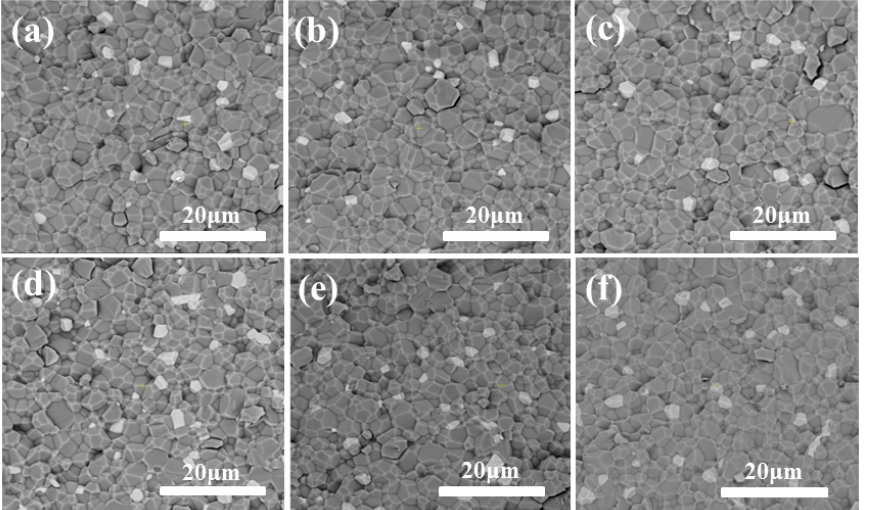
Figure 9. Microstructure of AlN ceramics prepared with modi fi ed AlN powder stored for 1 year. ( a ) Sample S0 (0.0 wt% OS), ( b ) sample S1 (0.2 wt% OS), ( c ) sample S2 (0.4 wt% OS), ( d ) sample S3 (0.06 wt% OS), ( e ) sample S4 (0.8 wt% OS), and ( f ) sample S5 (1.0 wt% OS).